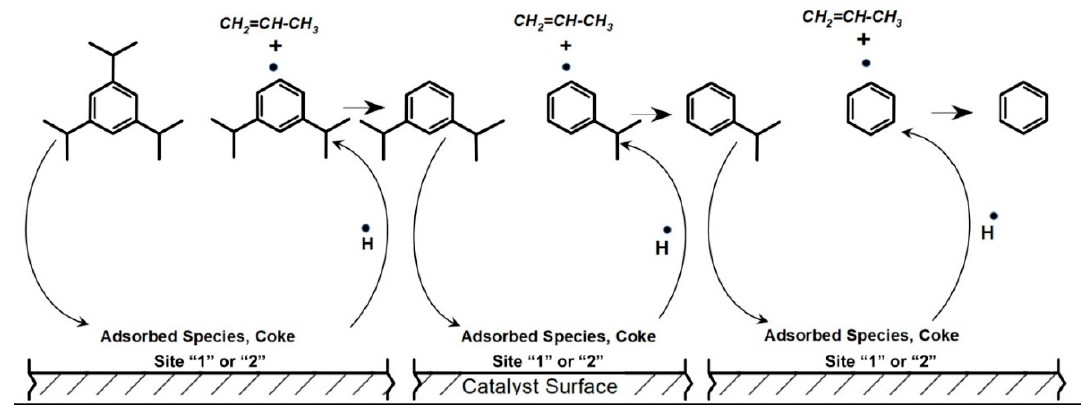
Figure 10. Schematic description of the catalytic 1,3,5-TIPB conversion showing the hypothesized cracking steps. Notes: ( a ) Sites 1 sites are sites located in the same particle; and ( b ) Sites 1 and 2 are placed in different particles.